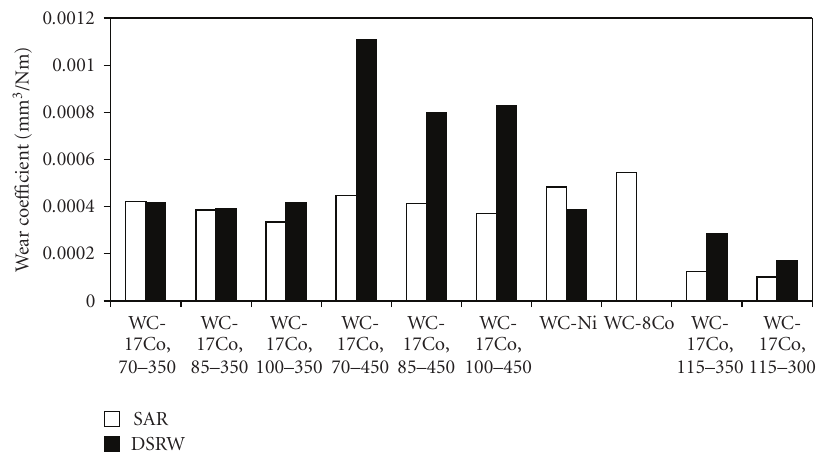
Figure 11: Results of the wet (SAR) and the dry (DSRW) abrasion